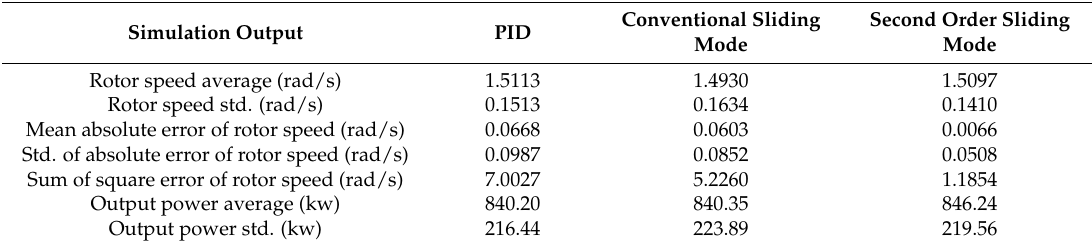
Table 4. Simulation results of turbine rotor speed, speed error and output power.